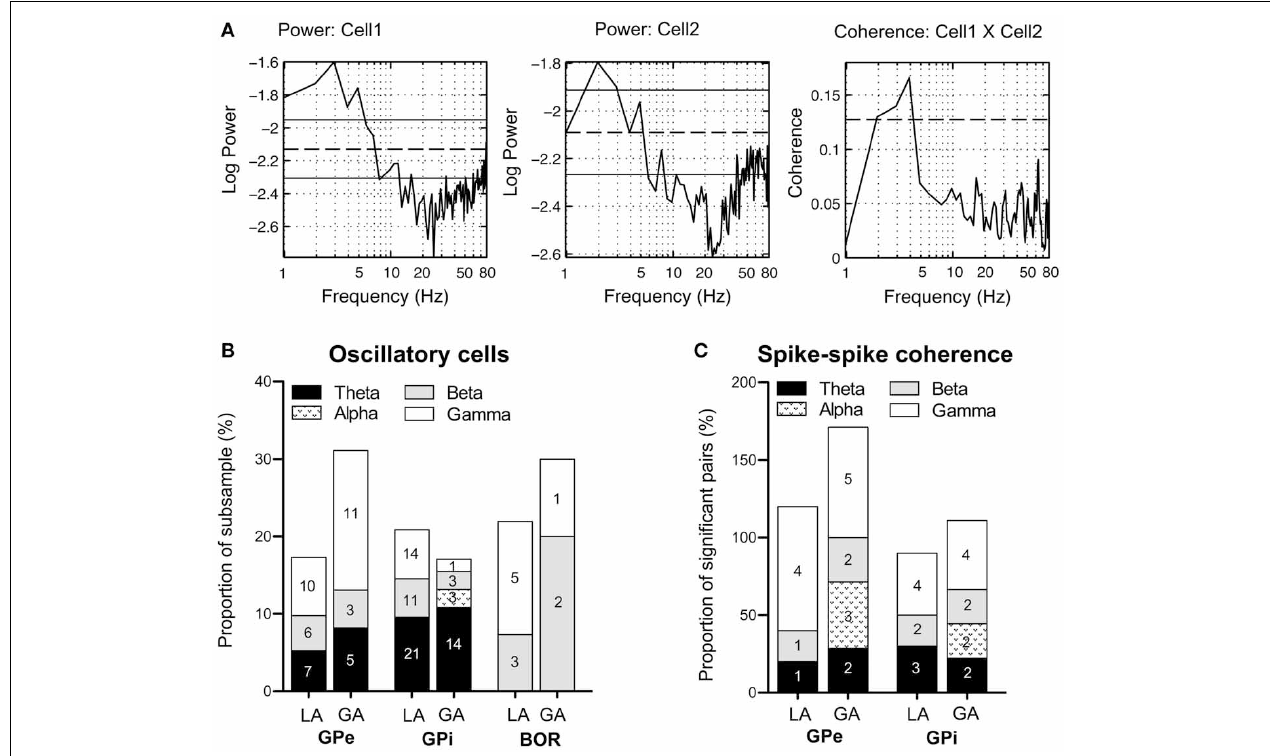
FIGURE 6 | Oscillatory properties and coherence in/between pallidal cells. (A) Frequency domain analysis of GPi unit correlation. (Left + middle panel) Log plots of estimated power spectra for two simultaneously recorded cells from the GPi of case 3 (awake surgery). Dashed horizontal lines represent the asymptotic value of each estimate and solid horizontal lines give the estimated upper and lower 95% confidence limits. (Right panel) Coherence estimate. The horizontal dashed line gives the estimated upper 95% confidence limit. (B) Stacked bar graph illustrating absolute numbers